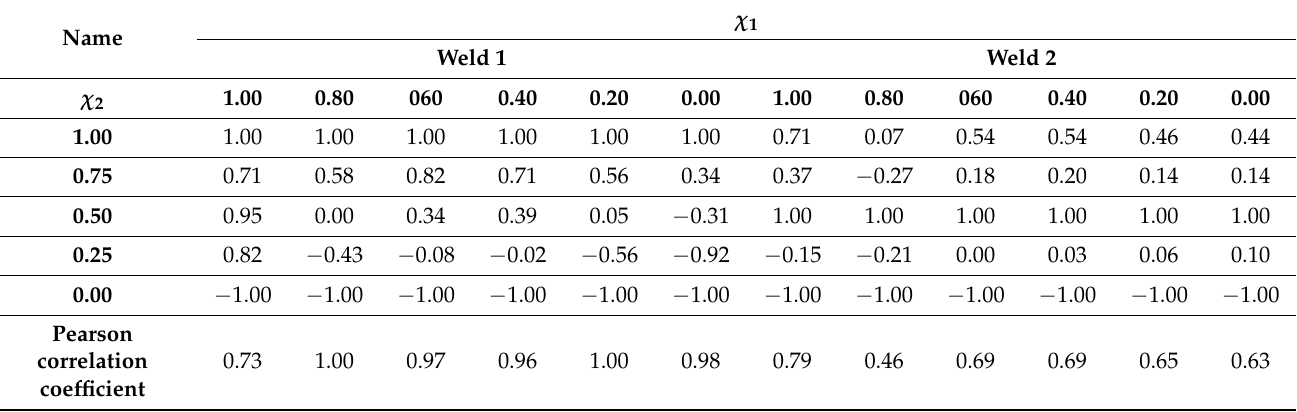
Table 6. The correlation of side column